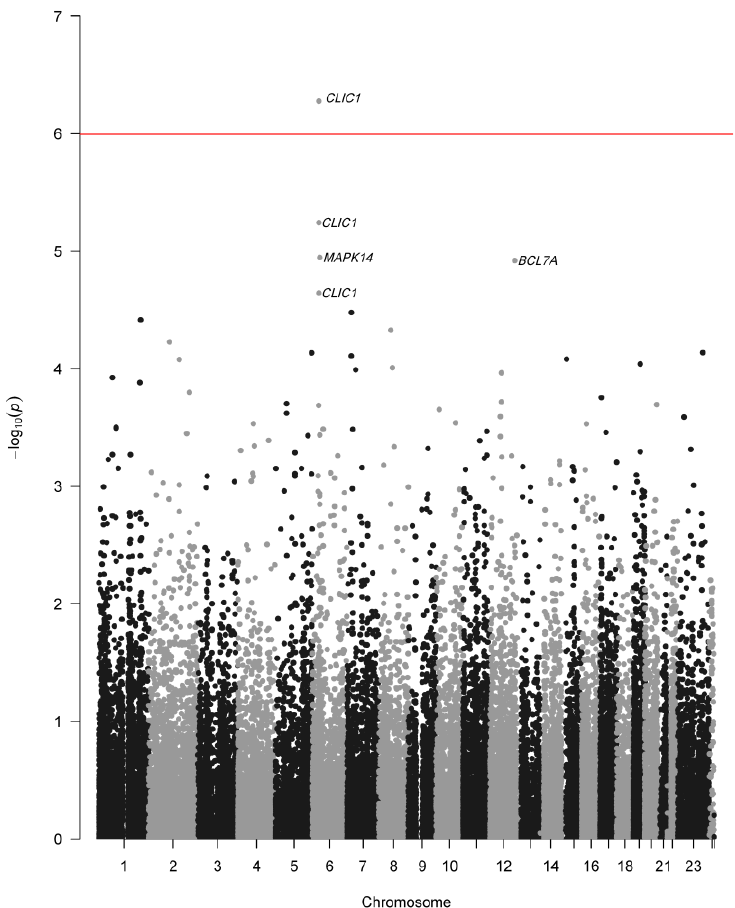
Figure 2. ANOVA p-values for 49,386 Microarray Probes. Negative log-transformed p -values for each probe, sorted by chromosome position. Black and grey coloring alternate to indicate different chromosomes. The dashed line shows the Bonferroni threshold for significance after correcting for multiple tests. Only one probe for the Chloride Intracellular Channel 1 (CLIC1) exceeded the significance